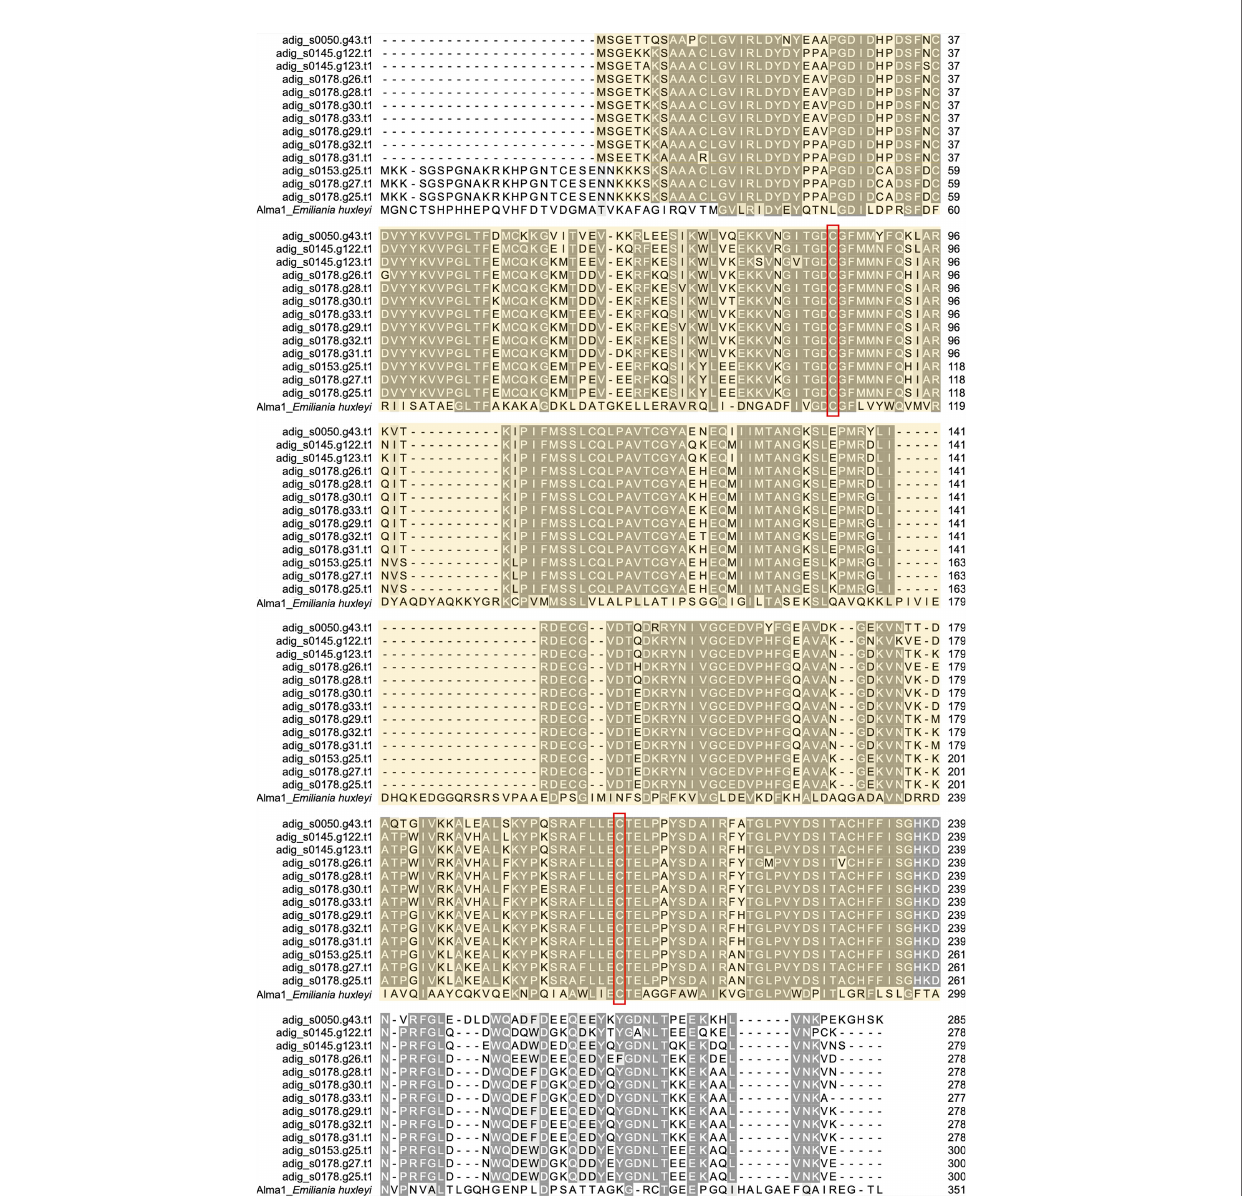
FIGURE 2 | Molecular characterization of DL-L genes in Acropora digitifera . Multiple sequence alignment of deduced amino acid sequences from 13 DL-L genes of A. digitifera and Emiliania huxleyi , Alma1 (KR703620.1). Identical residues are indicated in the same color. Lengths of amino acid sequences are shown at the right and positions of the Asp/Glu/hydantoin racemase superfamily conserved domain are shown in light yellow and the two putative active site residues are shown in red